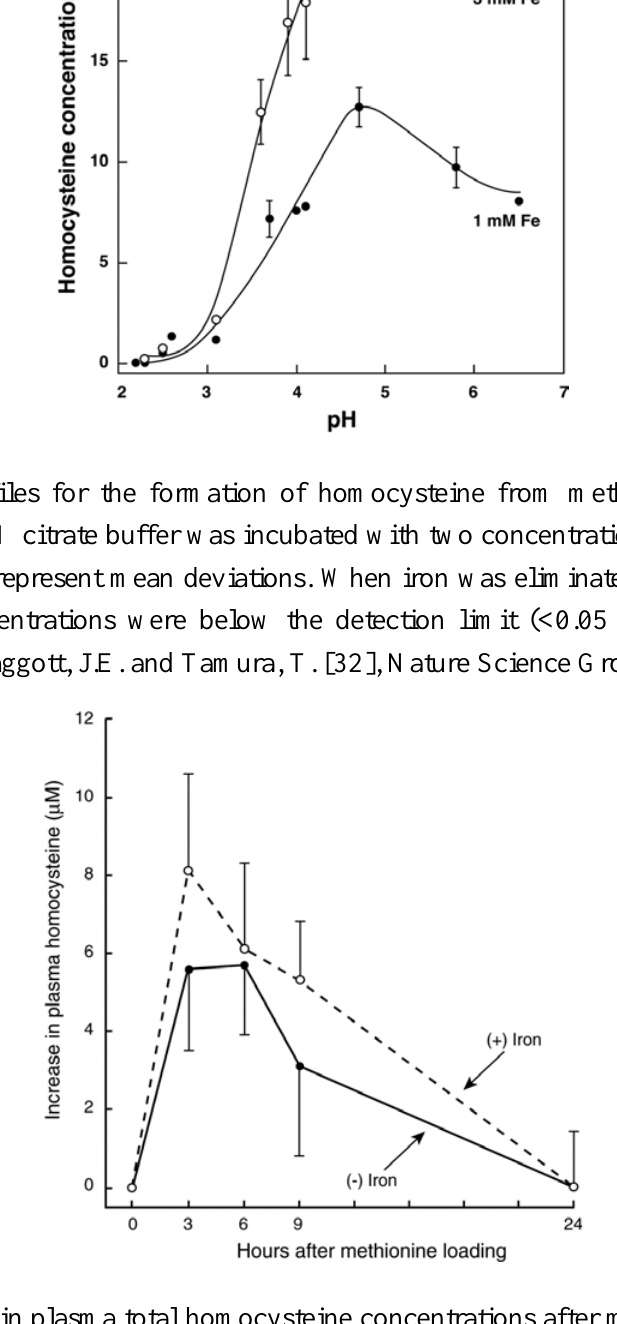
Figure 2. Changes in plasma total homocysteine concentrations after methionine load with or without FeSO 4 in five subjects. Mean (±SD) concentrations over baseline are plotted. Dashed and solid lines represent Met (0.17 mmol/kg of body weight) load with and without FeSO 4 (13.0 μmol/kg of body weight), respectively. The mean AUC after methionine load with iron was significantly greater than that after methionine alone ( p < 0.025, paired-Student’s t test). Adapted with permission from Baggott, J.E. and Tamura, T. [32], Nature Science Grouping ©